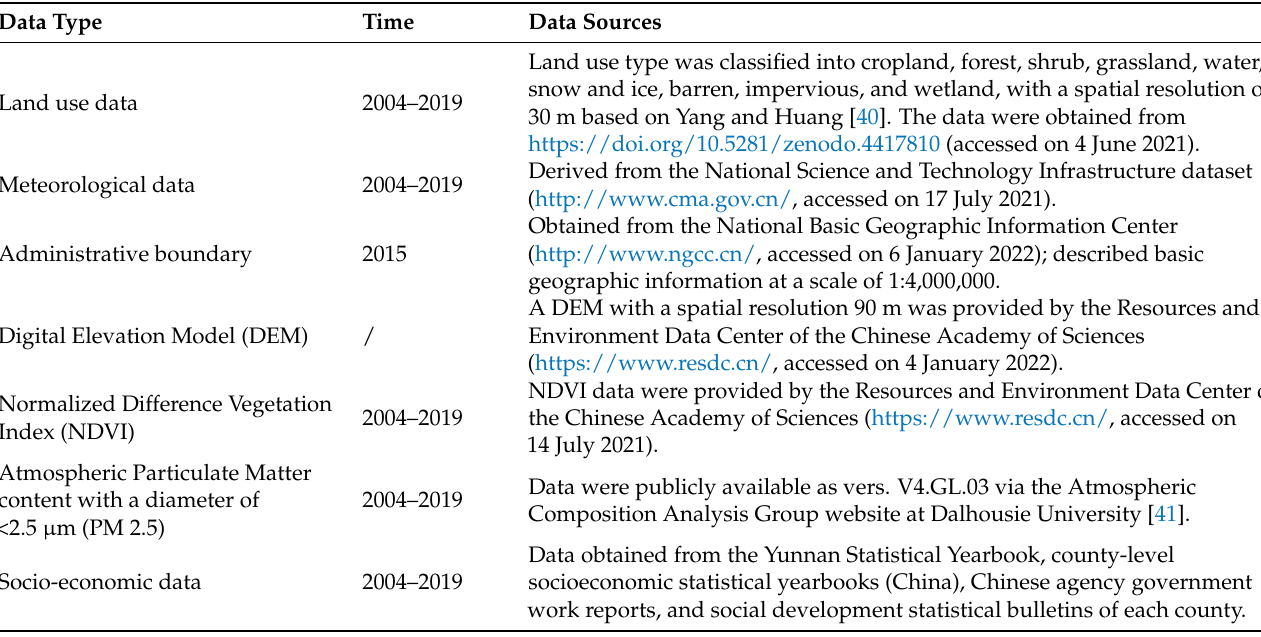
Table 1. Data information and